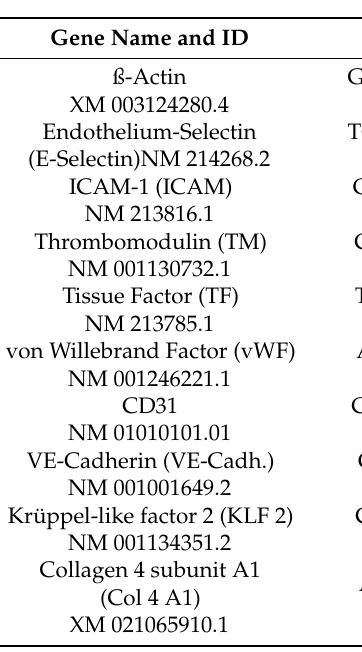
Table 2. Primer pairs used for gene expression